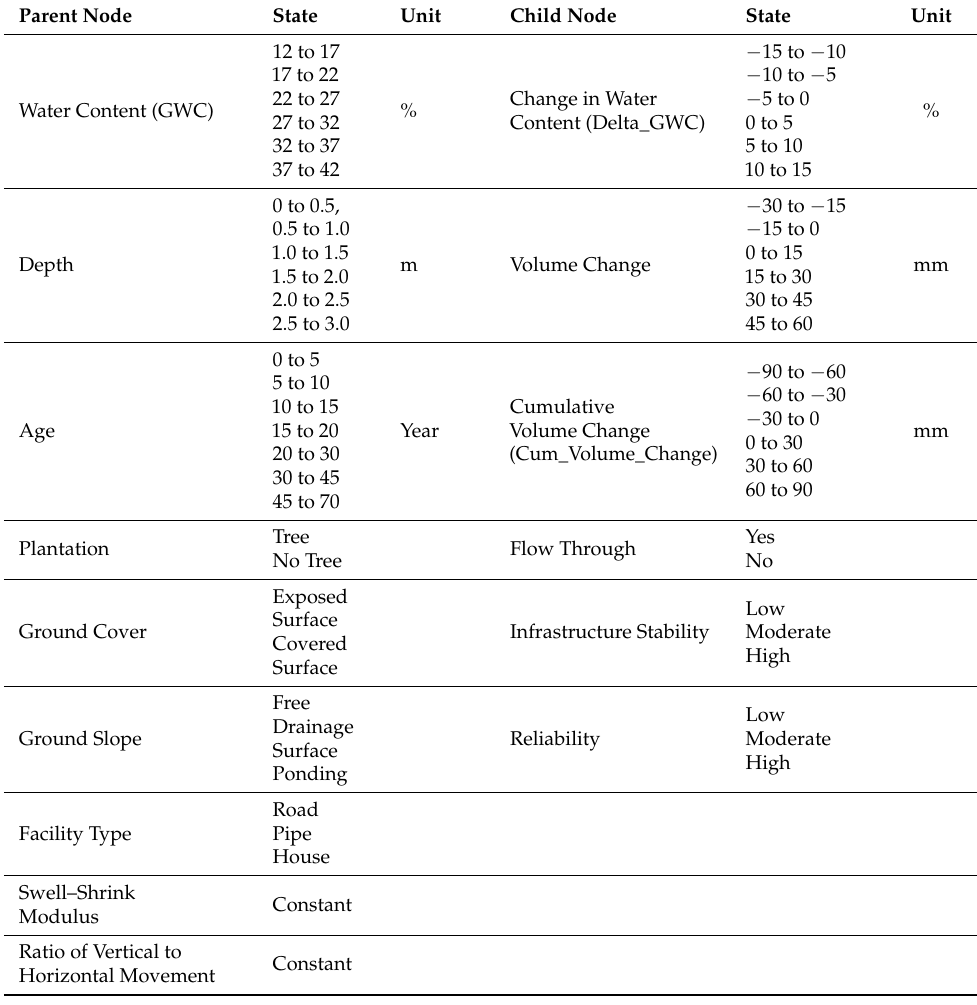
Table 1. States and units of parent and child